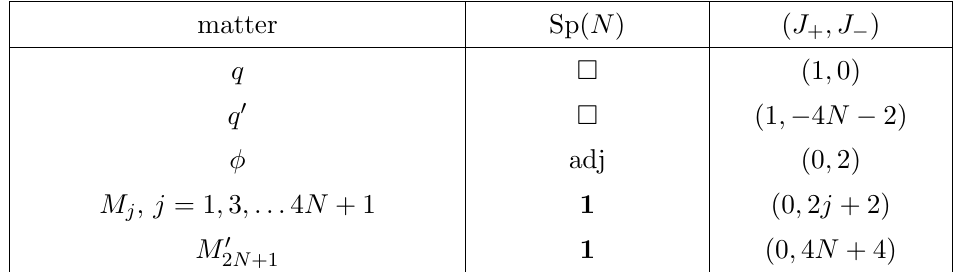
Table 2. The N = 1 matter content for the Sp( N ) gauge theory that (cid:13)ows to ( A 1 ; A 2 N ) Argyres- Douglas theory. (cid:26) is given by the principal embedding, and j takes values in the exponents of f . For f = so (4 N + 4), the exponents are f 2 N + 1; 1 ; 3 ; : : : ; 4 N + 1 g